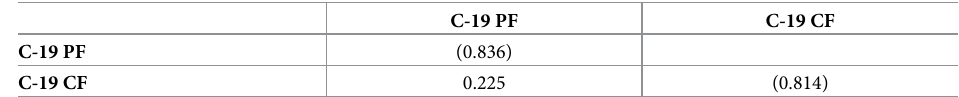
Table 4. Fornell–Larcker criterion.